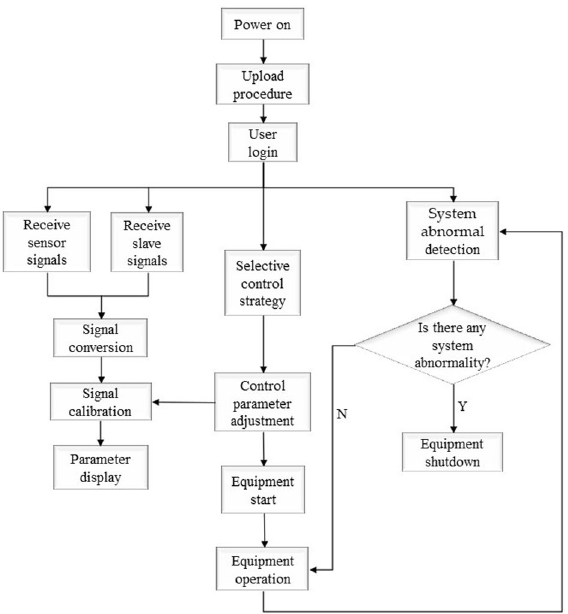
Figure 5. The running process of the CO 2 transcritical refrigeration experimental